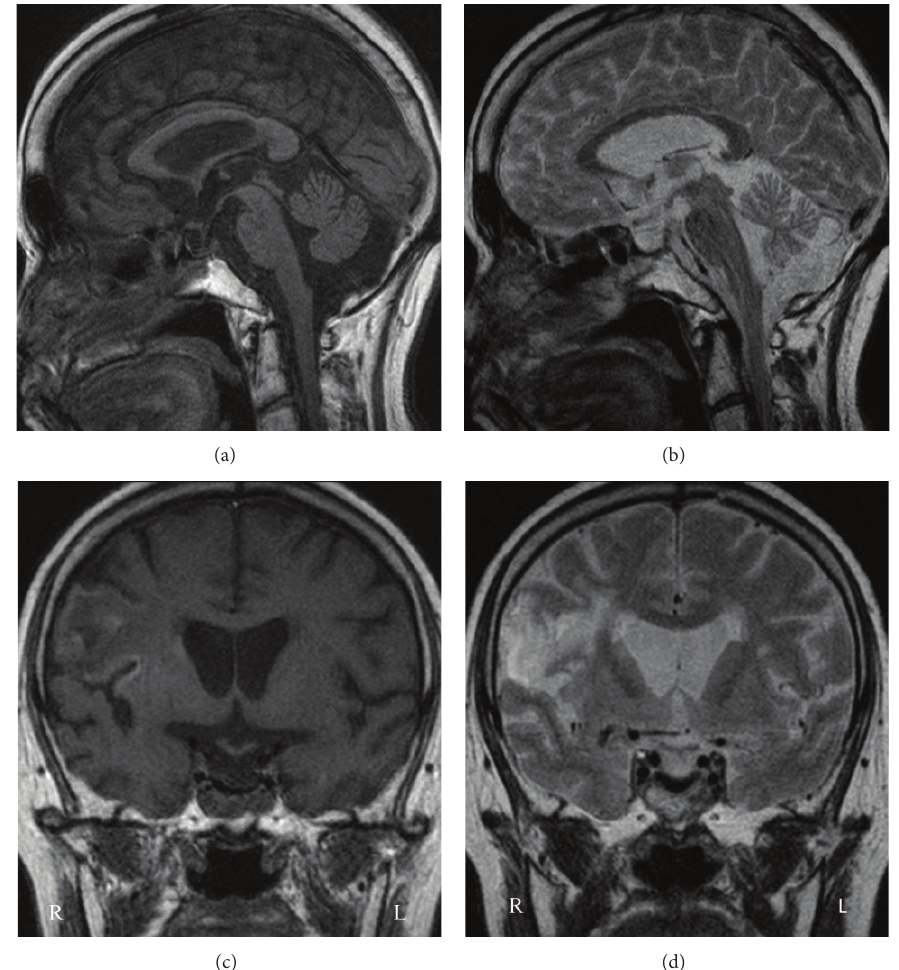
Figure 5: Sagittal and coronal views of the MRI showed the decompression of suprasellar region. (a, c) T1WI and (b, d) T2WI.